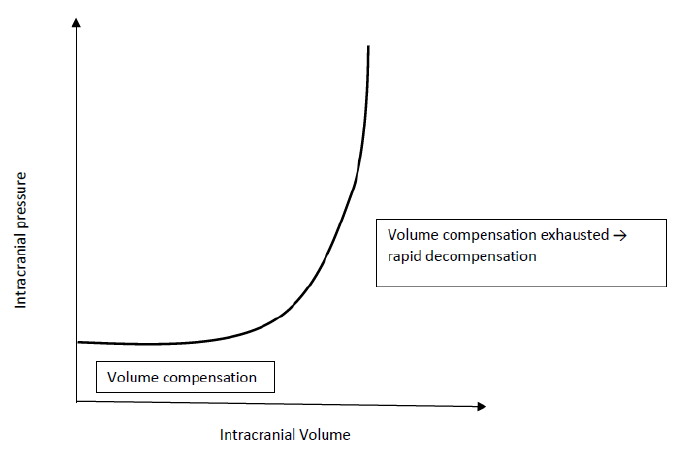
Figure 1. Intracranial compliance curve.